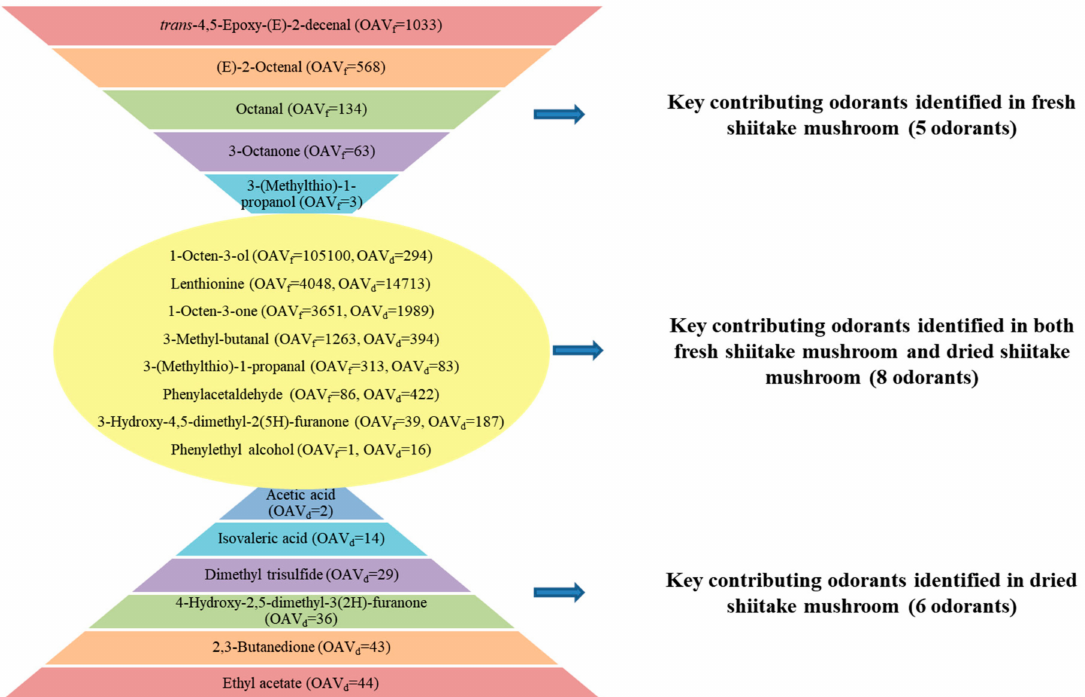
Figure 2. Distribution of key contributing odorants (OAV ≥ 1) identified in the fresh and dried shiitake mushrooms. OAV, odor activity value; OAV f , OAV in the fresh shiitake mushrooms; OAV d , OAV in the dried shiitake